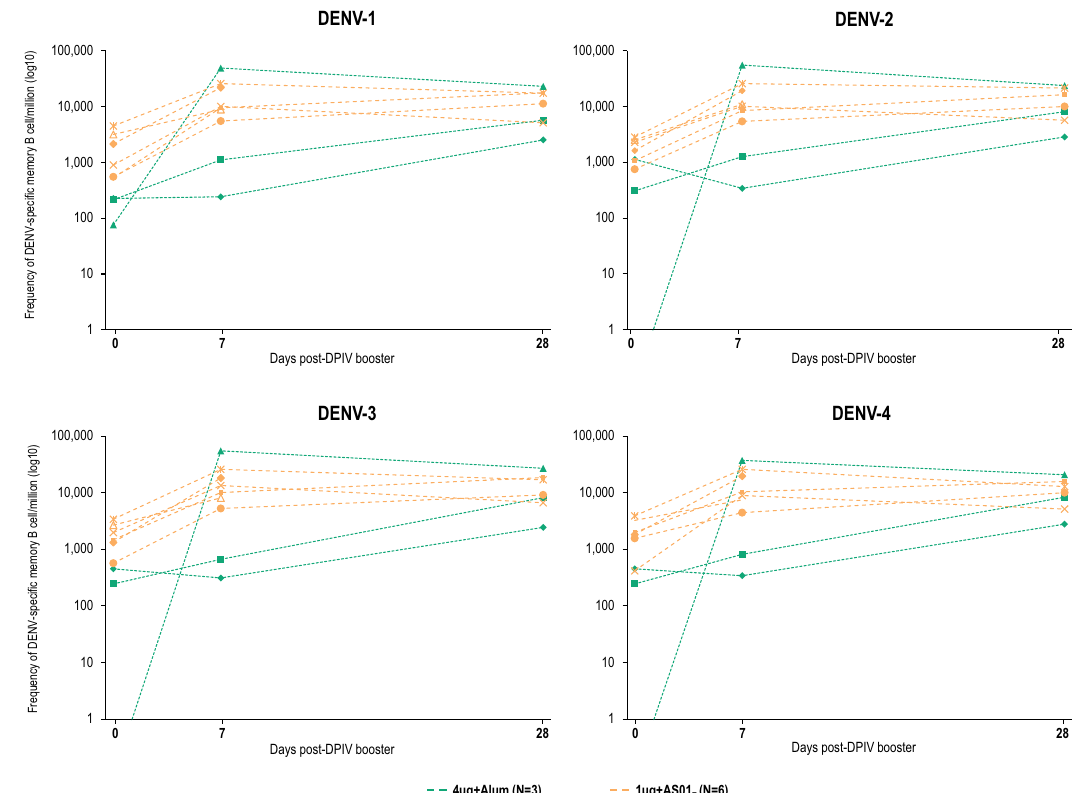
Fig. 2 Individual frequencies of memory B cells speci fi c to dengue virus serotypes 1 – 4. Values shown are for a subset of dengue-naive participants who received a DPIV booster (according-to-protocol cohort for immunogenicity for dose 3 subset). DENV, dengue virus; DPIV, tetravalent dengue puri fi ed inactivated vaccine; N, number of study participants who received a DPIV booster. Lines indicate responses of individual